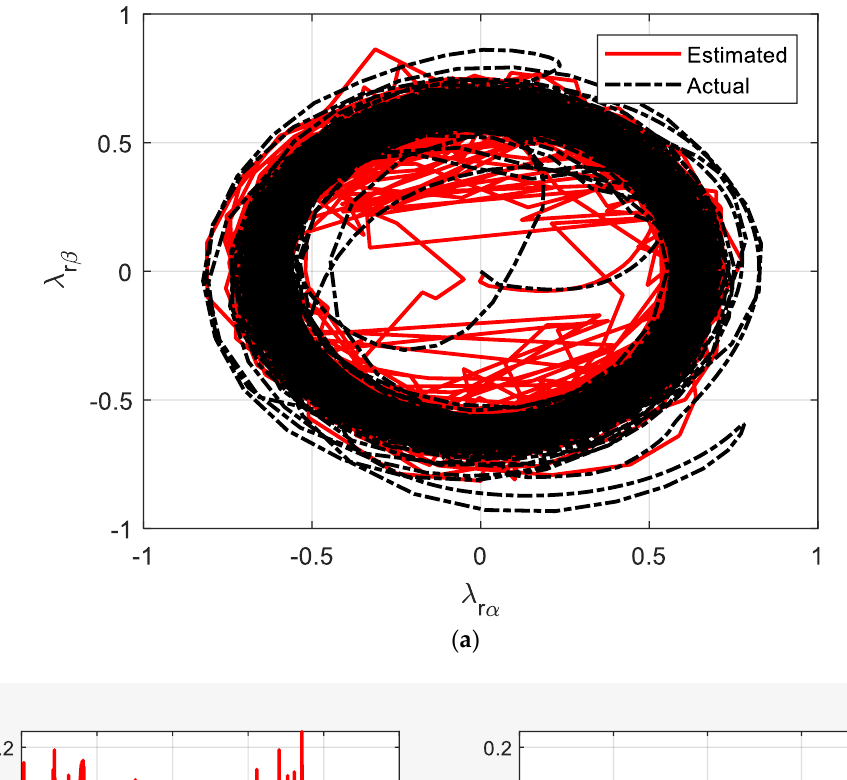
Figure 18. Dynamic performance of actual and estimated fluxes.